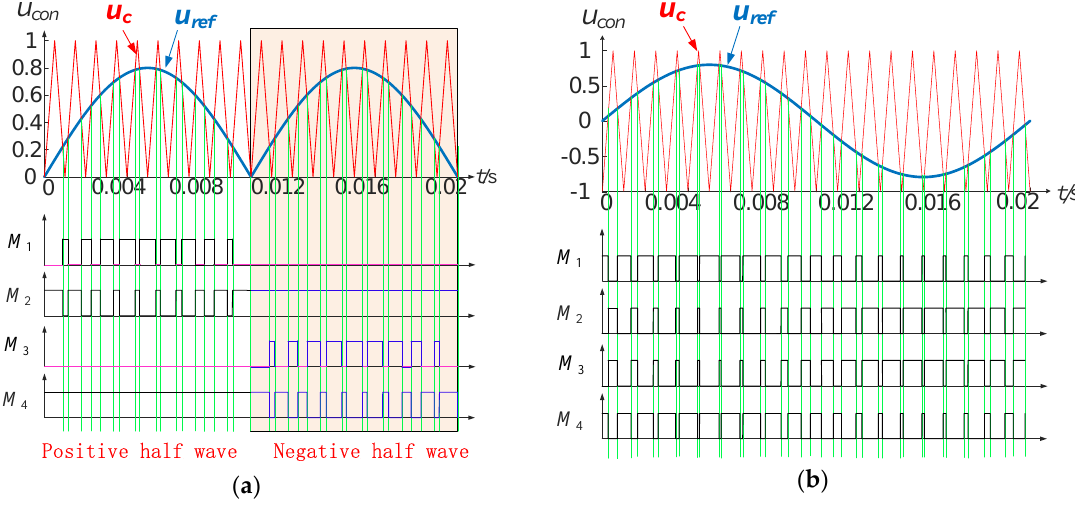
Figure 2. Sinusoidal Pulse Width Modulation (SPWM) principle. ( a ) Unipolar SPWM; ( b ) Bipolar SPWM.